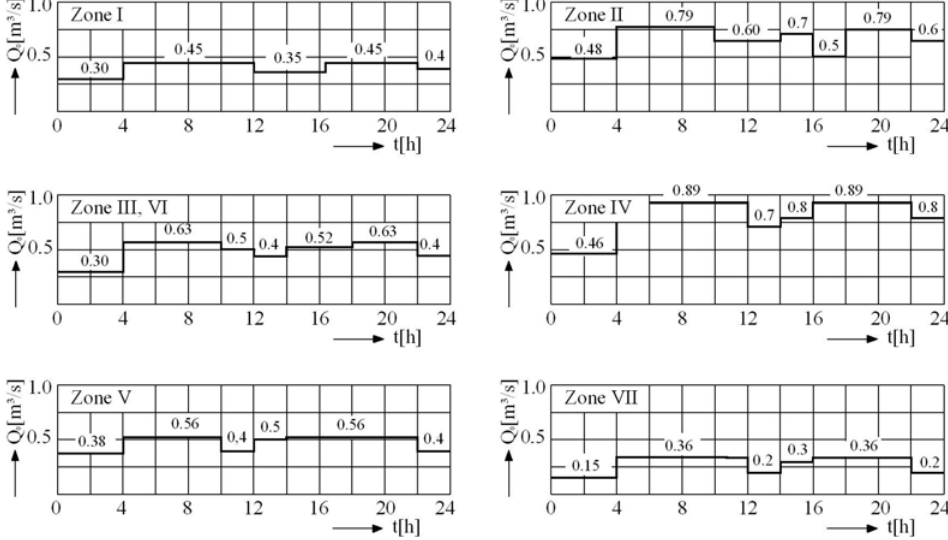
Figure 10. Pumping schedule for pumped storage tanks.